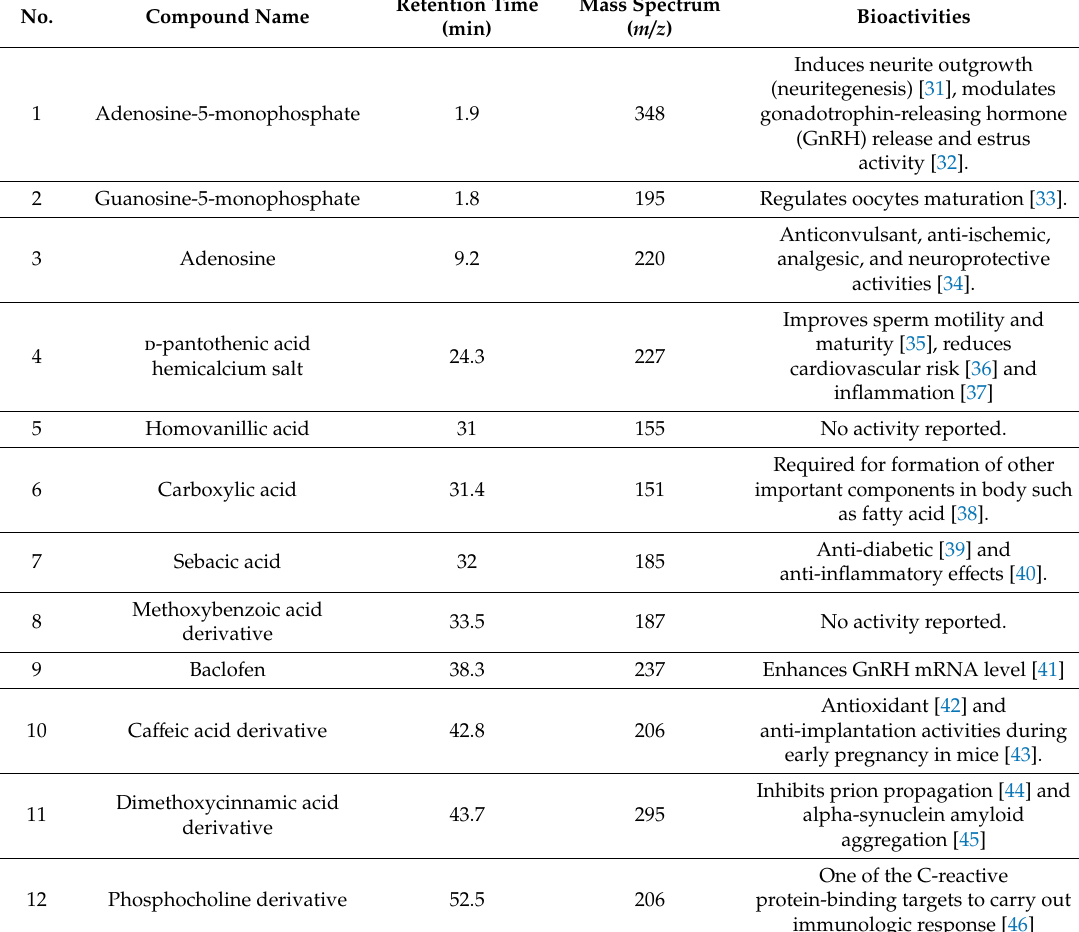
Table 2. LC–MS analysis of royal jelly and bioactivities of the compounds.